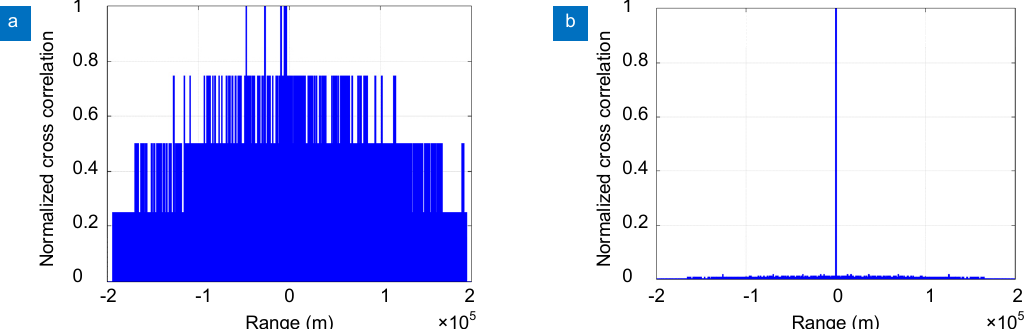
Fig. 6 | Normalized cross-correlation range images for the true random sequence (a) and the sparse pseudo-random sequence (b). a